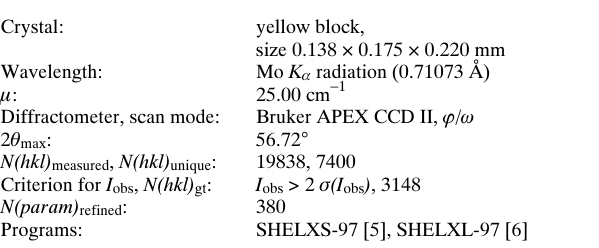
Table 1. Datacollection and